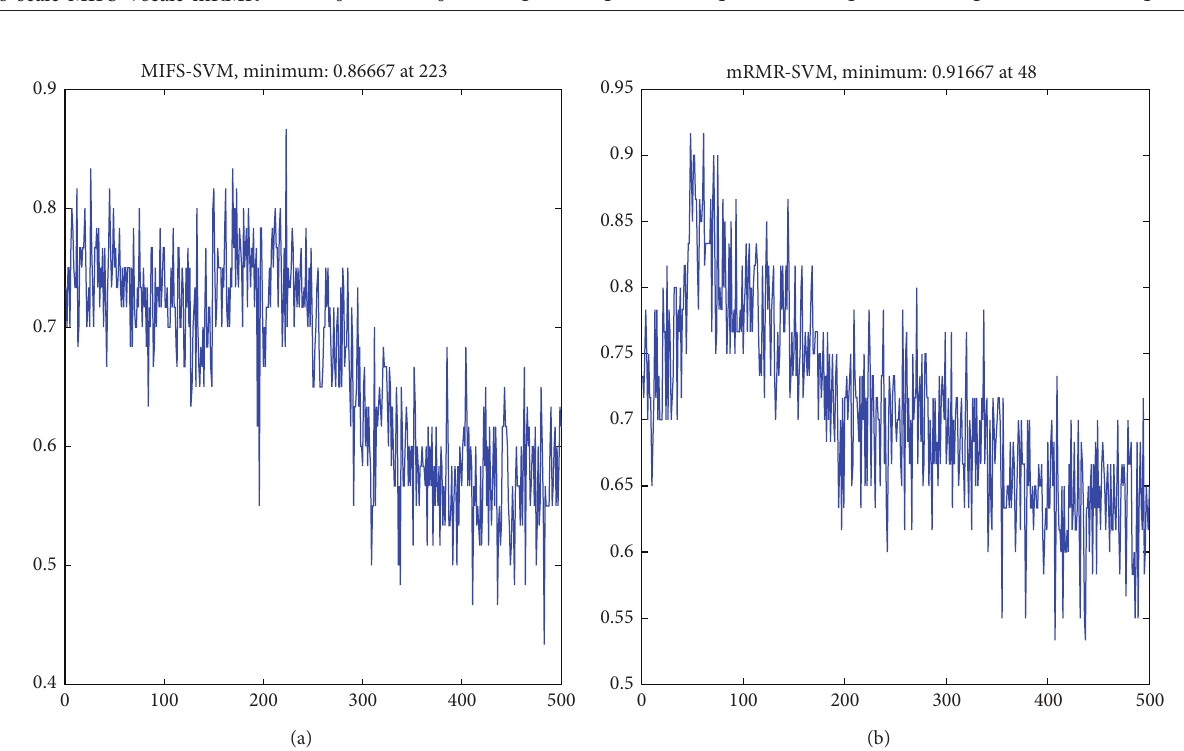
Figure 4: The comparison of classification accuracy using different feature selection criteria. (a) The classification accuracy using a different number of features selected by MIFS feature selection criterion. (b) The classification accuracy using a different number of features selected by mRMR feature selection